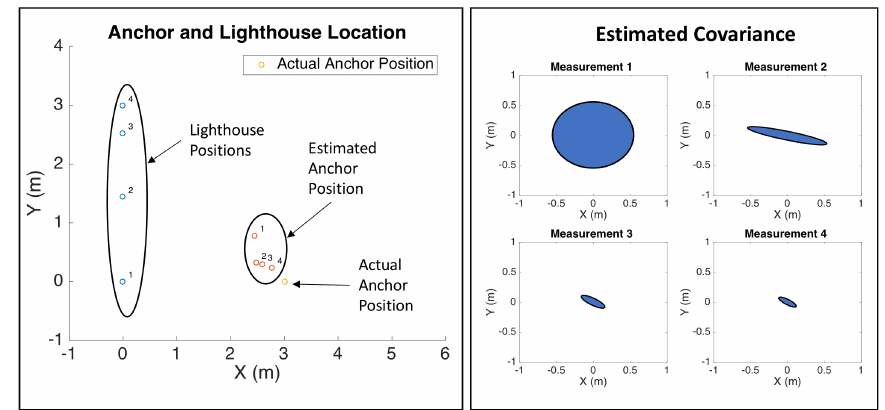
Figure 16. Simulation of wireless sensor node localization using lighthouse bearing measurements from a rotating quadrotor that is also moving translationally. In this simulation, the sensor node doesn’t know its location and is estimating its location from bearing measurements from the quadrotor lighthouse. As the anchor sensor mote receives more measurements, its location estimate improves, and estimated variance